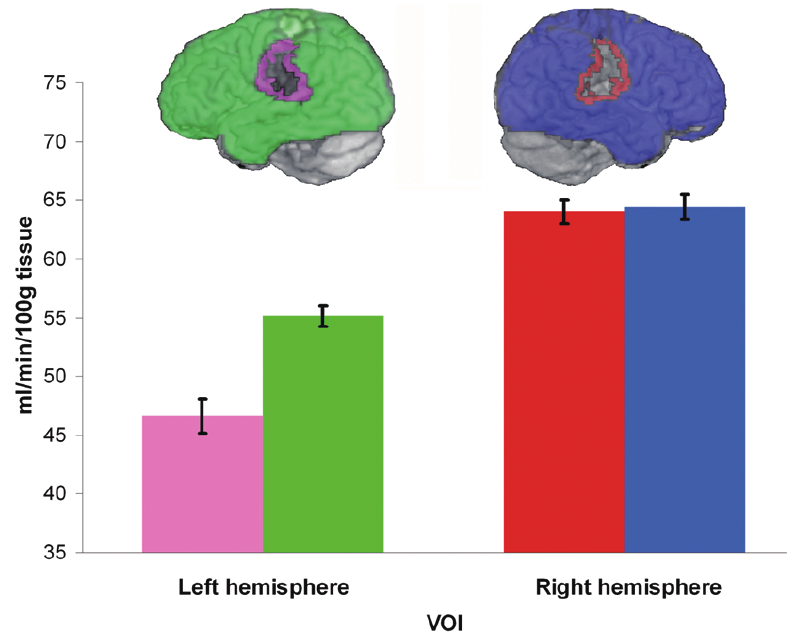
Fig. 1. The image on the left of the inset illustrates the left hemisphere peri-infarct (pink) and remaining (green) masks. The image on the right of the inset illustrates homologous masks (red and blue). The graph depicts results from the volume of interest analysis, in which perfusion values in the peri-infarct and remaining cortex were compared across the two hemispheres. The error bars denote normalized standard error. tistical Package for the Social Sciences) version